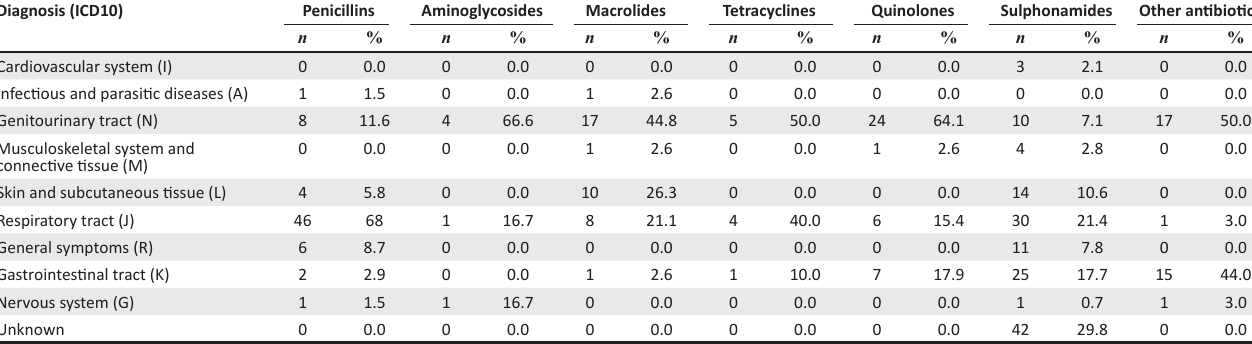
TABLE 5: Antibiotic prescribing following diagnosis. Diagnosis